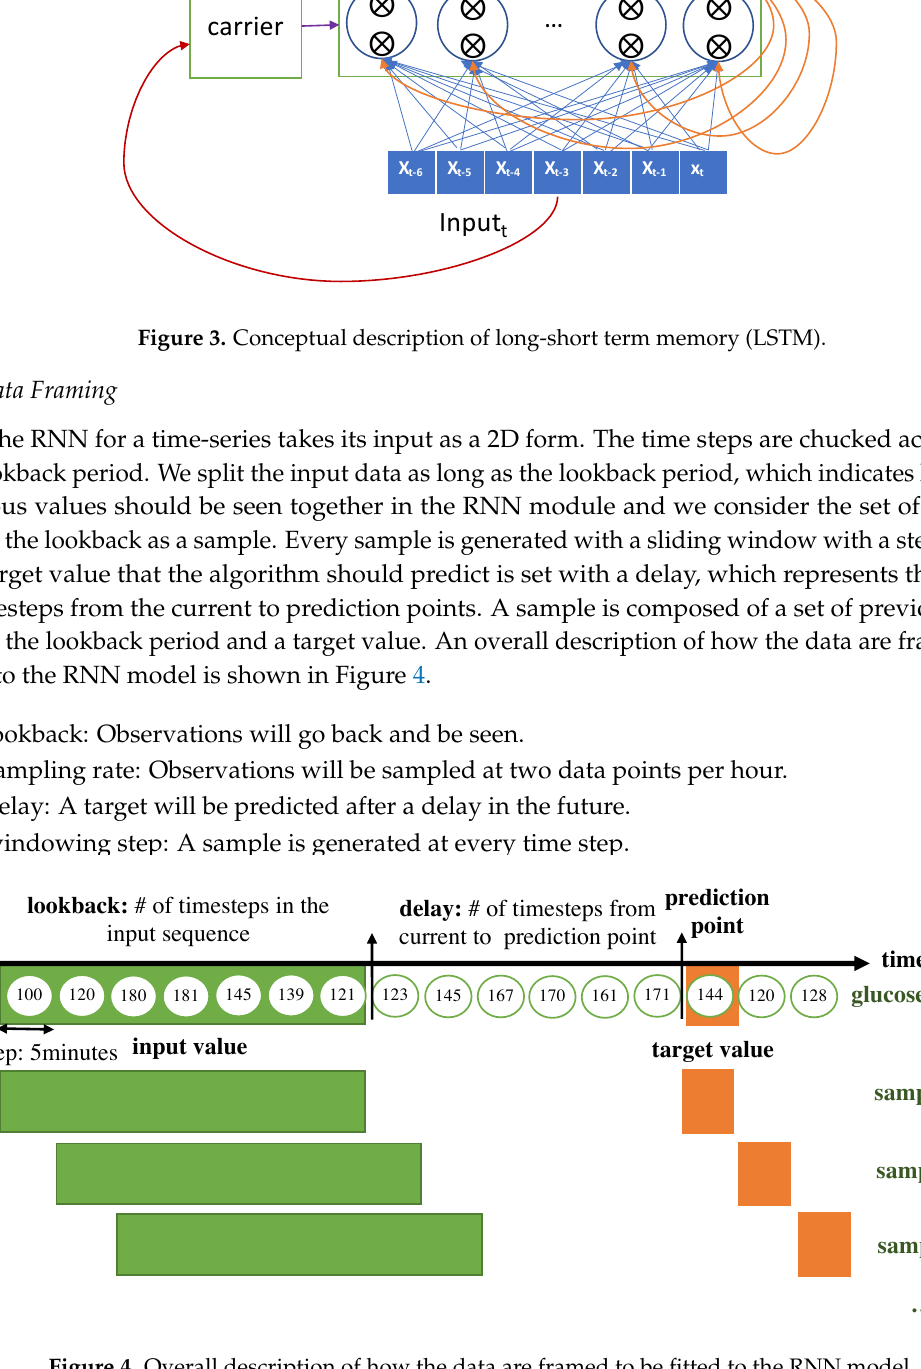
Figure 4. Overall description of how the data are framed to be fitted to the RNN